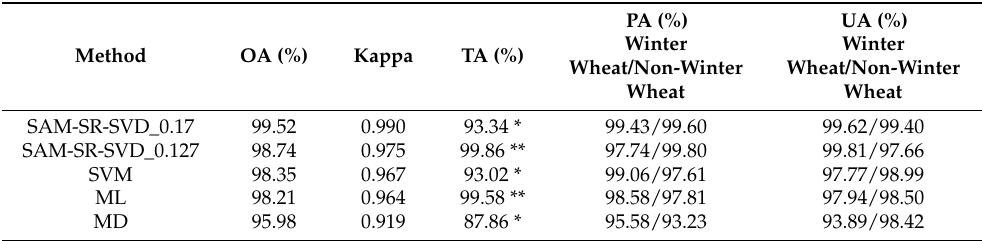
Figure 11. Local winter wheat mapping results based on different methods: ( a ) Sentinel-2 image (RGB: 432, 8 April 2018), ( b ) result of spectral angle mapper with spectral reconstruction method based on singular value decomposition (SAM-SR-SVD) with a threshold of 0.17, ( c ) result of SAM-SR-SVD with a threshold of 0.127, ( d ) result of maximum likelihood (ML), ( e ) result of support vector machine (SVM), and ( f ) result of minimum distance (MD). Comparison of the accuracy of winter wheat mapping by different methods in Puyang